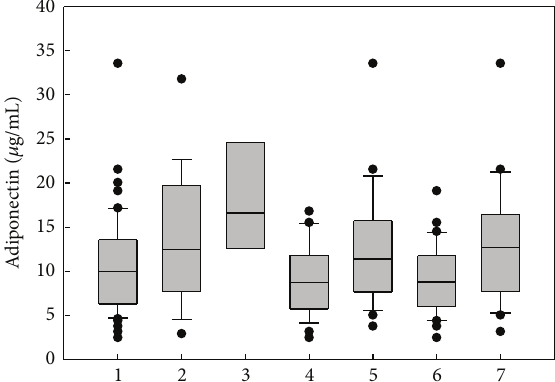
Figure 2: Median concentration of adiponectin in peripheral blood of OSA patients and healthy subjects. Plots are the 10th, 25th, 75th, and 90th percentiles as vertical boxes with error bars. 1: all OSA patients; 2: healthy subjects; 3: OSA patients with BMI < 25; 4: obese OSA patients; 5: no obese OSA patients; 6: OSA patients with metabolic syndrome; 7: OSA patients without metabolic syndrome. There was significant difference between groups 3 and 4, 6, and 7 in Kruskal-Wallis test ( 𝑝 < 0.05